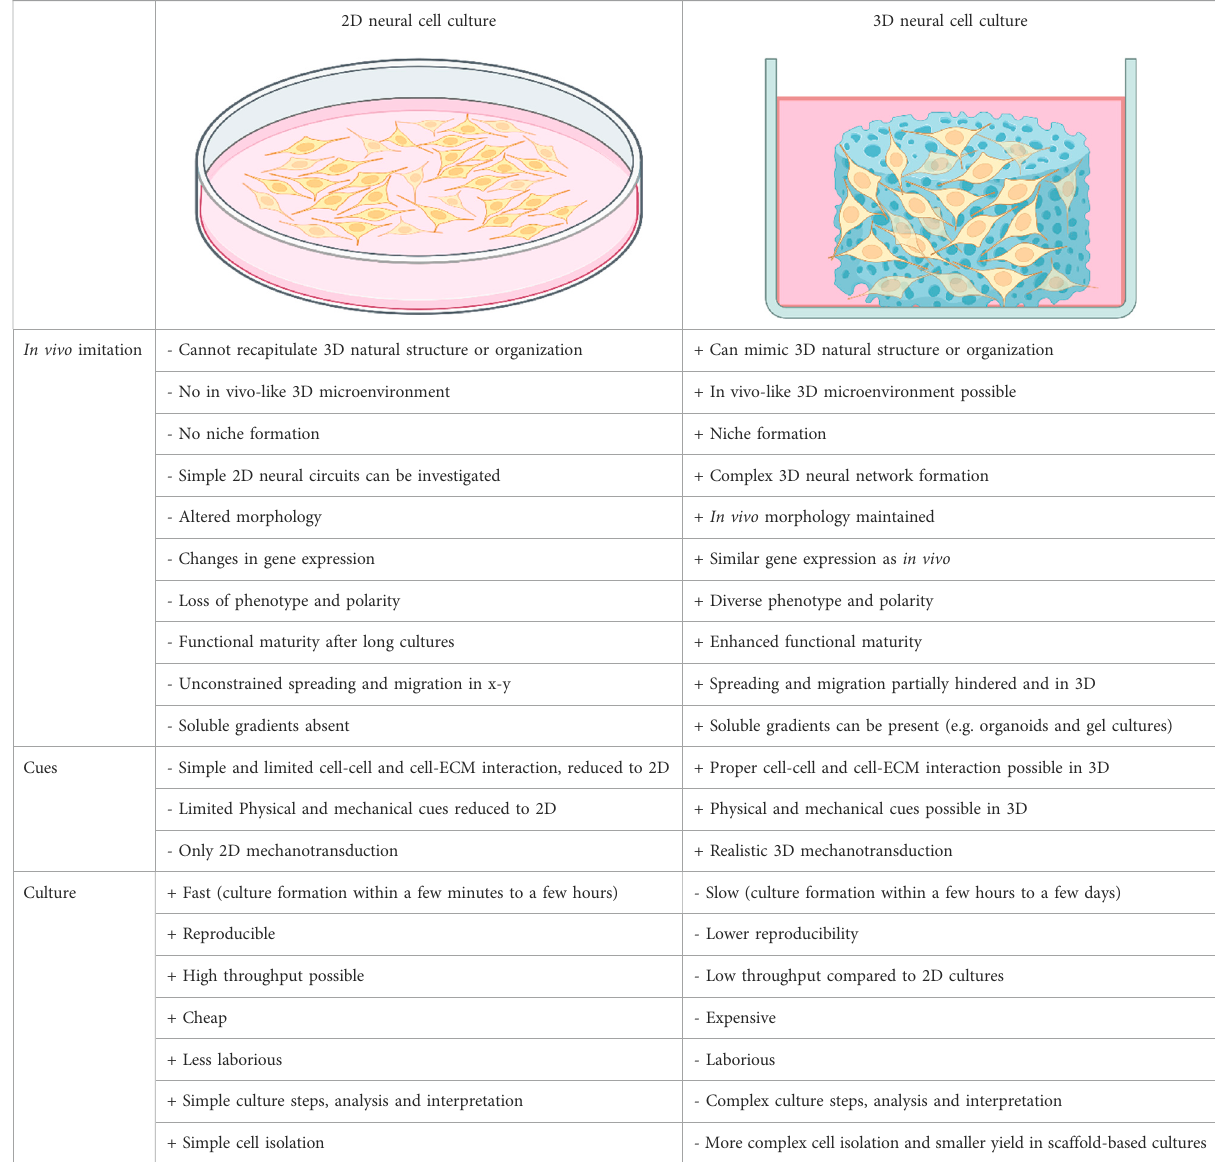
TABLE 1 Overview of 2D vs . 3D in vitro brain models with related advantages (+) and disadvantages (-) (Baker and Chen, 2012; Kapa ł czy ń ska et al, 2018; Sun et al,